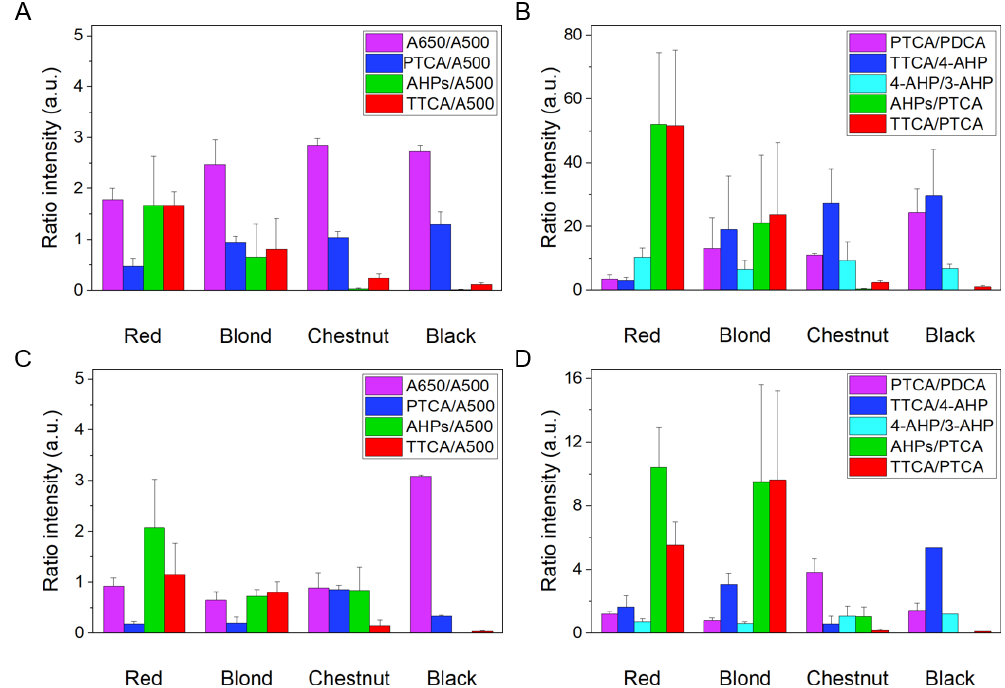
Figure 4. Ratios of the examined markers for melanosomes ( A , B ) and melanin nanoaggregates ( C , D ) of the studied melanins. Values represent mean ± SEM. 4-AHP/3-AHP, AHPs/PTCA, and TTCA/PTCA ratios in melanosomes are multiplied by a factor of 10 to increase clarity. A650/A500 ratios are also multiplied by a factor of 10.